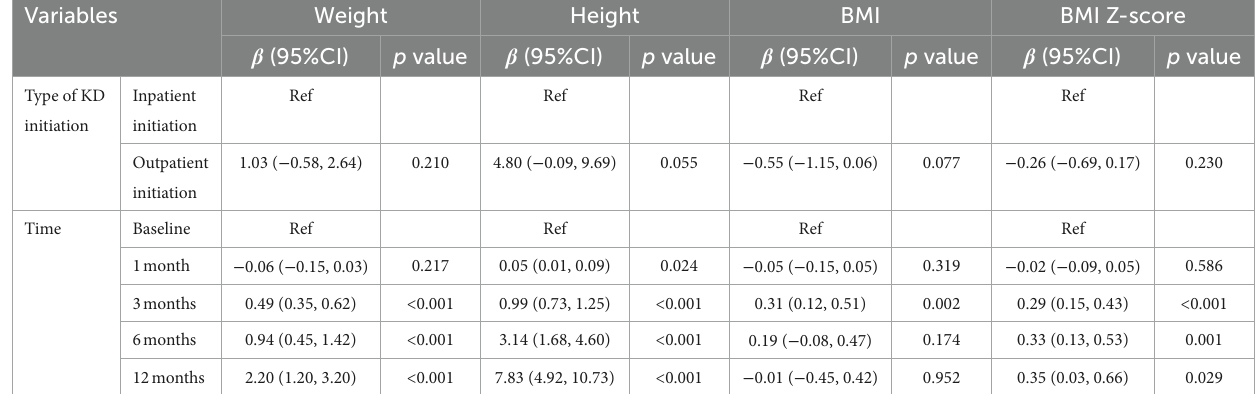
TABLE 5 Comparison of the growth in the different groups and follow-up times based on the GEE. Variables